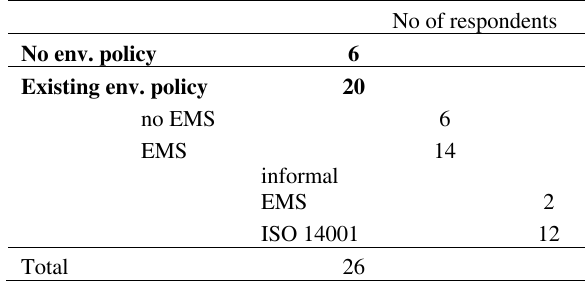
Table 4. Implementation of EMSs